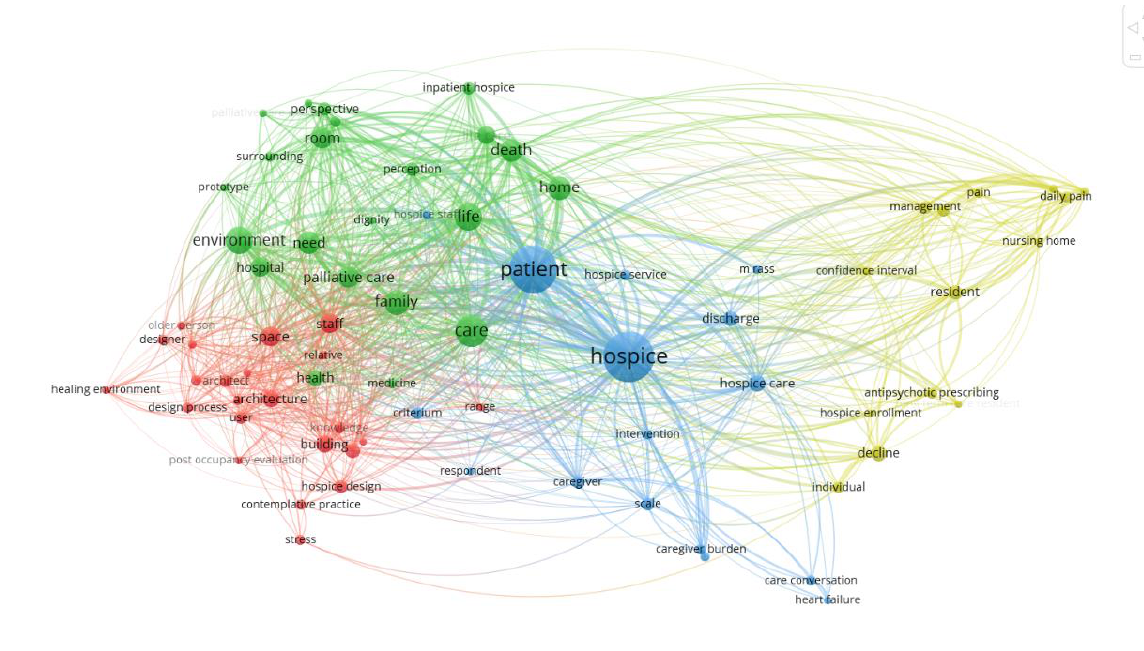
Figure 5: Visualization map resulting from the words selected showing incidences and links between keywords It is evident that the repetitive and keywords in association with hospice is non design related and that the keywords are patients, caregivers, family and care, while those associated with design are few and with little to no links or connectors (Figure 6)